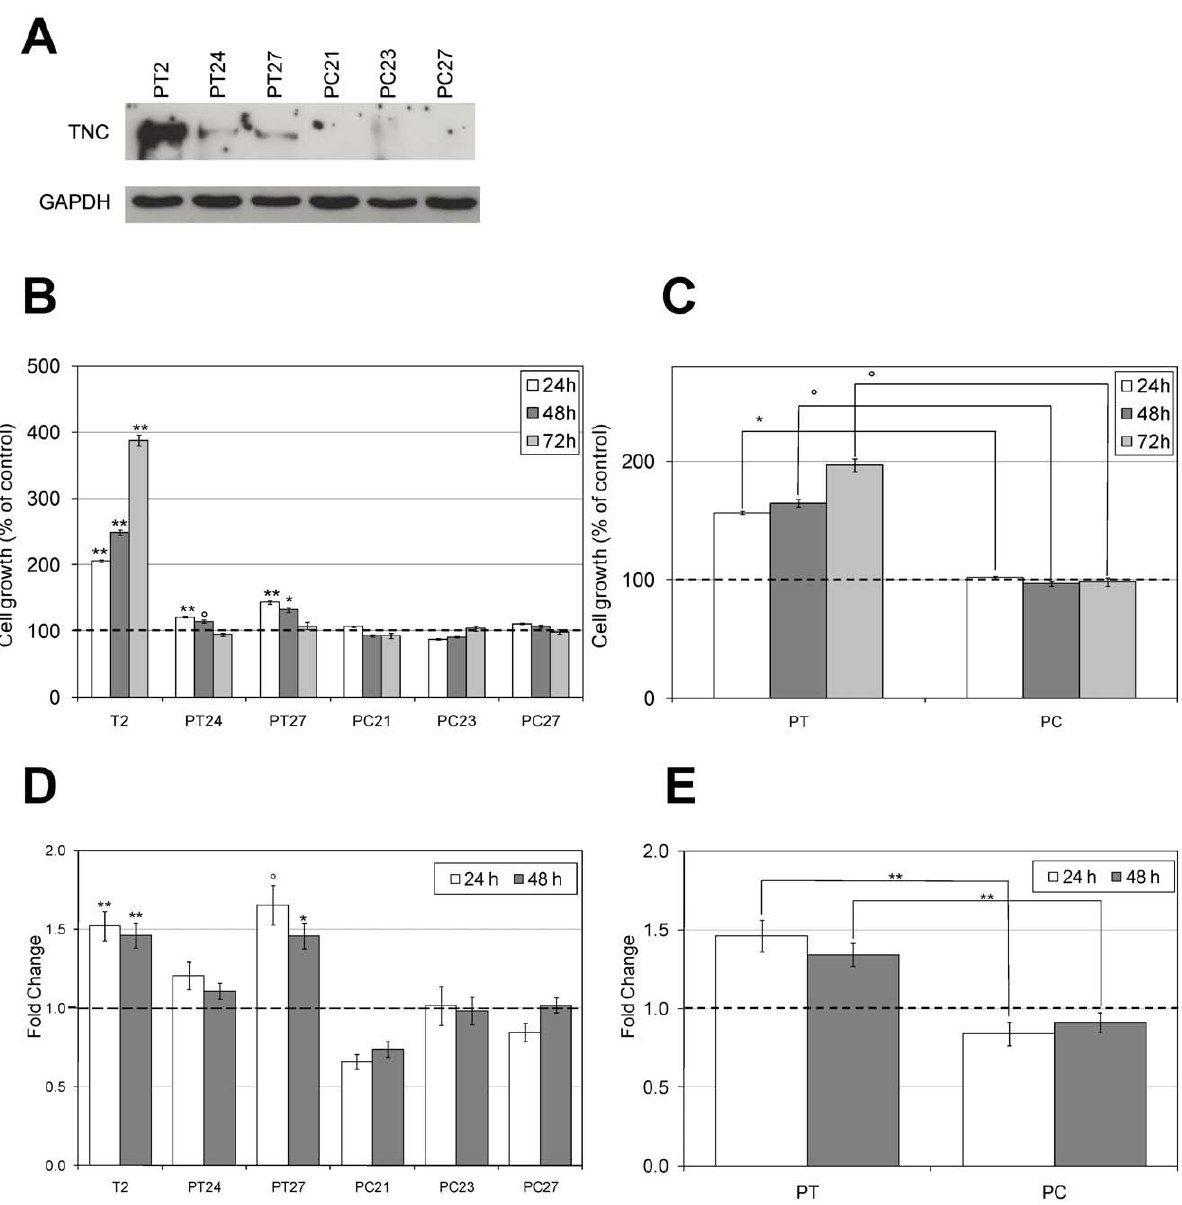
Figure 3. Effects of endogenous TNC on cell proliferation and migration. PANC-1 cells were stably transfected with a vector driving the expression of large TNC (PANC-T2, PANC-T24 and PANC-T27 cells) and with the empty vector (PANC-C21, PANC-C23 and PANC-C27 cells). (A) Immunoblotting of precipitated cell culture medium of the transfected PANC-1 cells grown up to 80% confluence. To ensure that a comparable number of transfected cells was the source of secreted TNC, GAPDH expression in whole cell extracts was tested. PANC-T2 cells show the highest levels of secreted TNC, while lower levels are observed in PANC-T24 and PANC-T27. The control clones in comparison do not show any TNC secretion. (B) Cells were grown in complete medium. Growth was determined with MTT assay at different time points (24, 48 and 72 hours). Data are calculated as mean + / 2 s.e.m. of three experiments and are expressed as percentage compared to the PANC-1 cells ( u p , 0.05, *p , 0.01, **p , 0.001, Students two-tailed t test). The proliferation rate is significantly higher for PANC-T2 at all time points (p , 0.001), for PANC-T24 at 24 hours (p , 0.001) and at 48 hours (p=0.022) and for PANC-T27 at 24 (p , 0.001) and 48 hours (p=0.009). (C) The proliferation of all the PANC-1 positive clones (PT) compared to the mock transfected cells (PC) is significantly higher for each tested time point (24 hours: p=0.004, 48 hours: p=0.012, 72 hours: p=0.026) (D) Transfected PANC-1 cells were plated, after 24 hours medium was changed with medium containing 0.1% FBS and, after overnight incubation, the monolayer was scraped with a 10 m l pipette tip. Data are calculated as described in B. In comparison to the non transfected PANC-1 cells, migration is significantly faster for PANC-T2 (p , 0.001 at both time points) and for PANC-T27 (p=0.042 at 24 hours; p=0.009 at 48 hours). (E) All together, the PANC-1 positive clones (PT) migrate significantly faster compared to the mock transfected cells (PC) at both time points (p , 0.001). doi:10.1371/journal.pone.0021684.g003 (not shown). As for cell adhesion, TNC seemed to have opposite As shown in Fig. 4, TNC and FN had a slight enhancing effect effects depending on the experimental set up. In fact phospho-Akt on the phosphorylation state of Aktin the PANC-1 and SU.86.86 was slightly up-regulated when comparing TNC coated plates vs cell lines during the first steps of cell adhesion (45 min). This effect uncoated plates and down-regulated when comparing FN/TNC was not evident anymore after 24 hours and at later time points